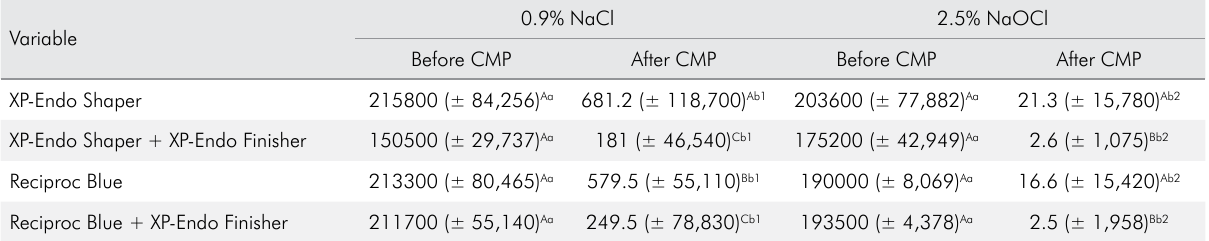
Table. Mean (± SD) of CFU/mL before and after chemomechanical preparation using 0.9% NaCl and 2.5% NaOCl in the different